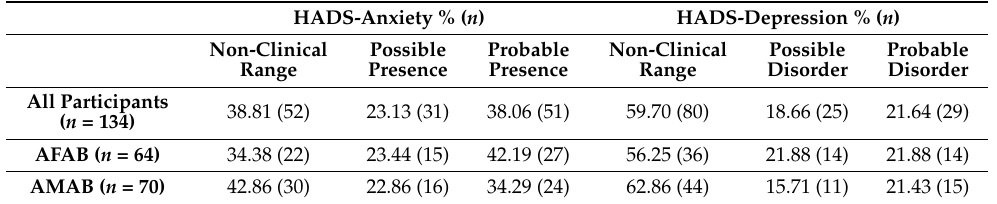
AMAB: Assigned male at birth; AFAB: Assigned female at